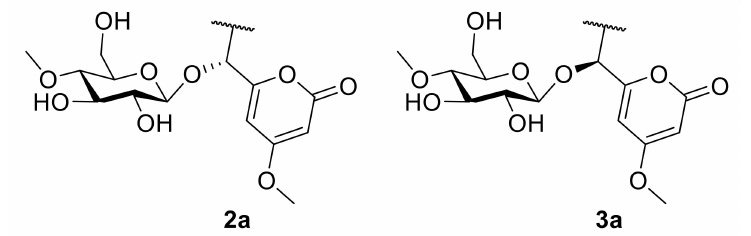
Figure 5. The structures of truncated model compounds 2a and 3a